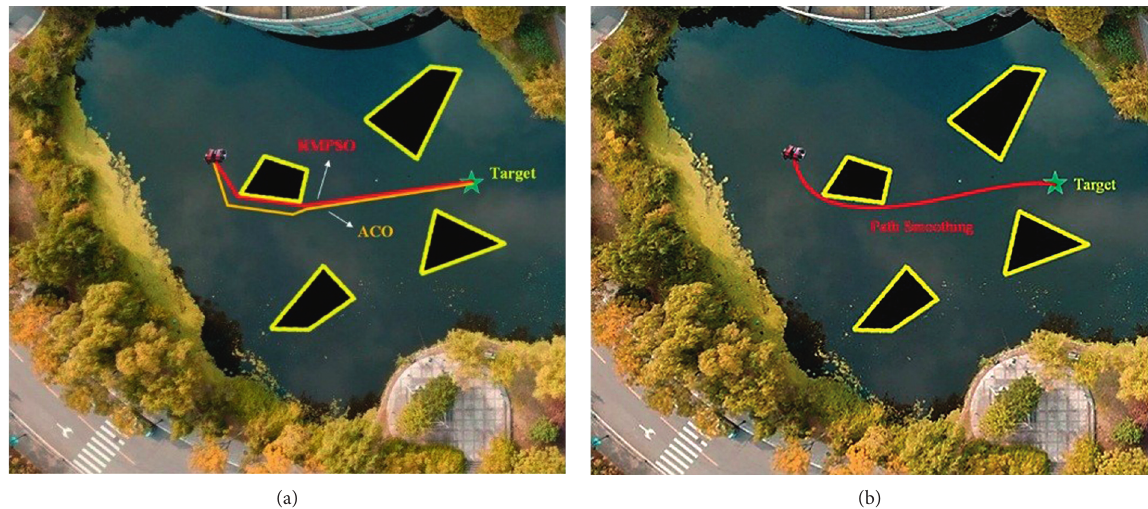
Figure 16: Path planning in the lake. (a) Comparison of the ACO algorithm and RMPSO algorithm. (b) Bezier curve smoothing